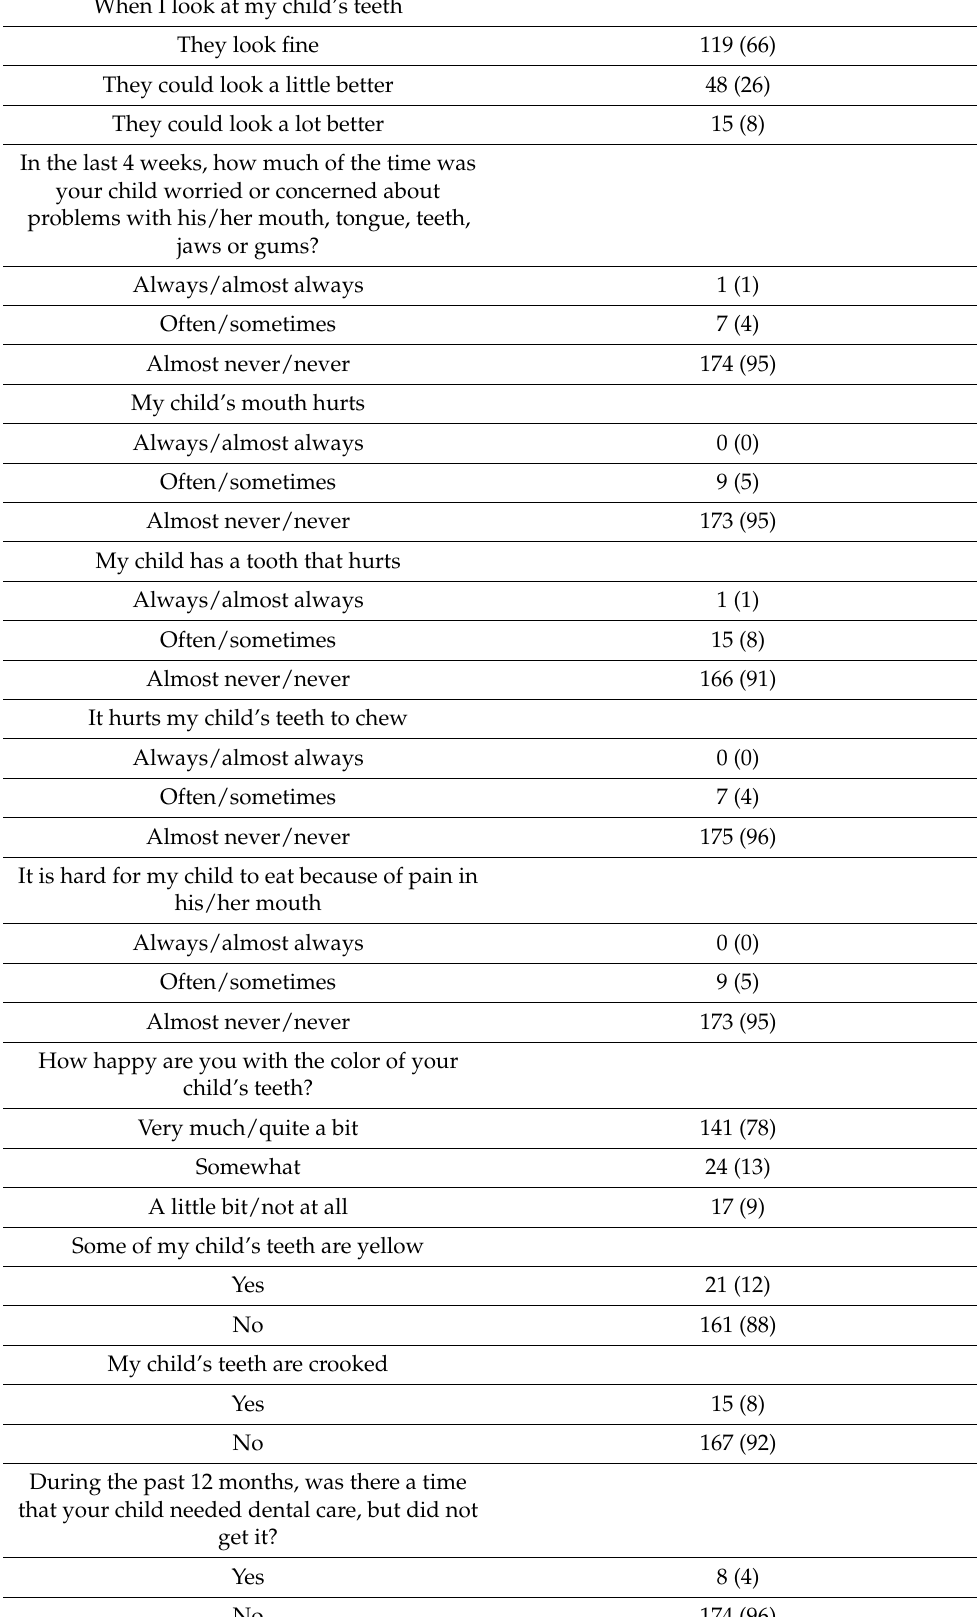
Table 2. Cont. Sample